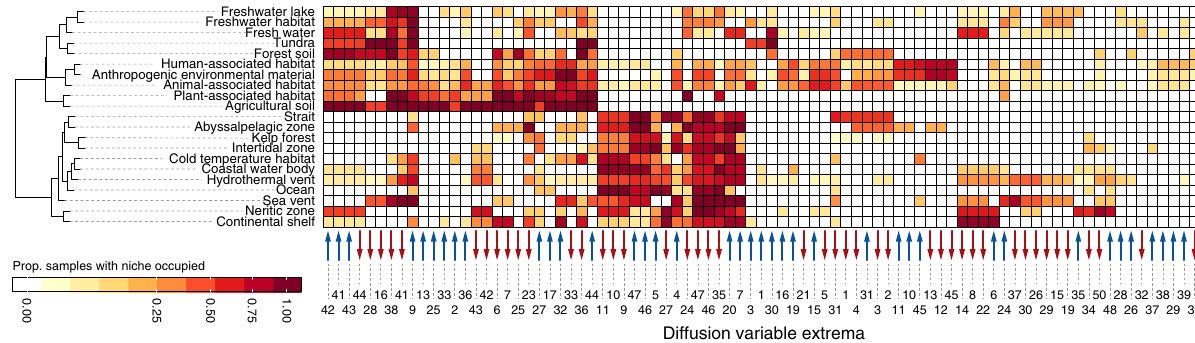
Fig. 4 Bacterial communities map to characteristic regions of niche space. Metabolic niche pro fi les of samples from different ecosystem types (rows) in the Earth Microbiome Project 62 . Columns correspond to different diffusion variable extrema. Darker tiles indicate that a larger fraction of community censuses contained taxa that mapped to those extrema. Blue and red arrows along the horizontal axis denote positive and negative variable extrema respectively. A hierarchical cluster analysis groups ecosystems with similar niche pro fi